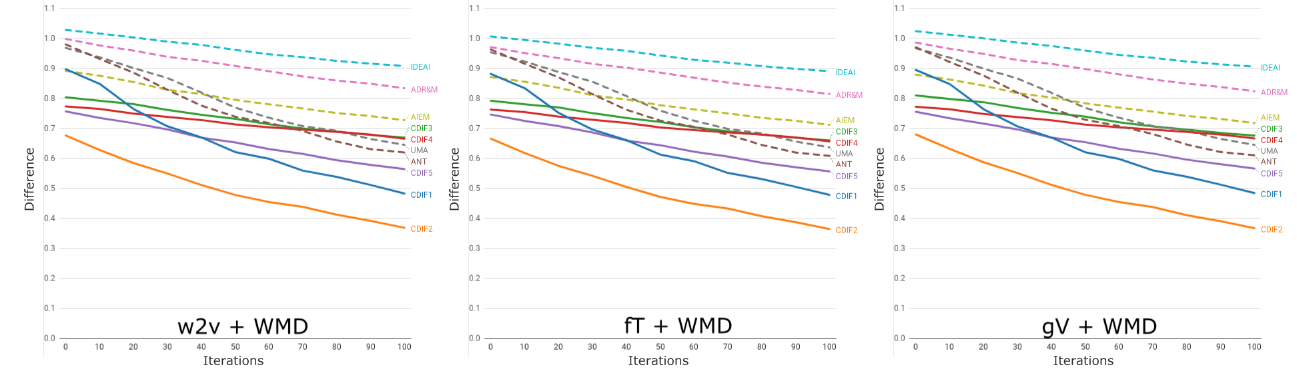
Figure 3. Performance of WMD in the validation task for w2v ( left ), fT ( center ), and gV ( right ). In this case, some papers of the same group (CDIF1, CDIF2, and CDIF5) are always considered as more similar to the base paper (CDIF) than the rest. Furthermore, in all cases, the distance decreases with larger number of phrases passed from one to the